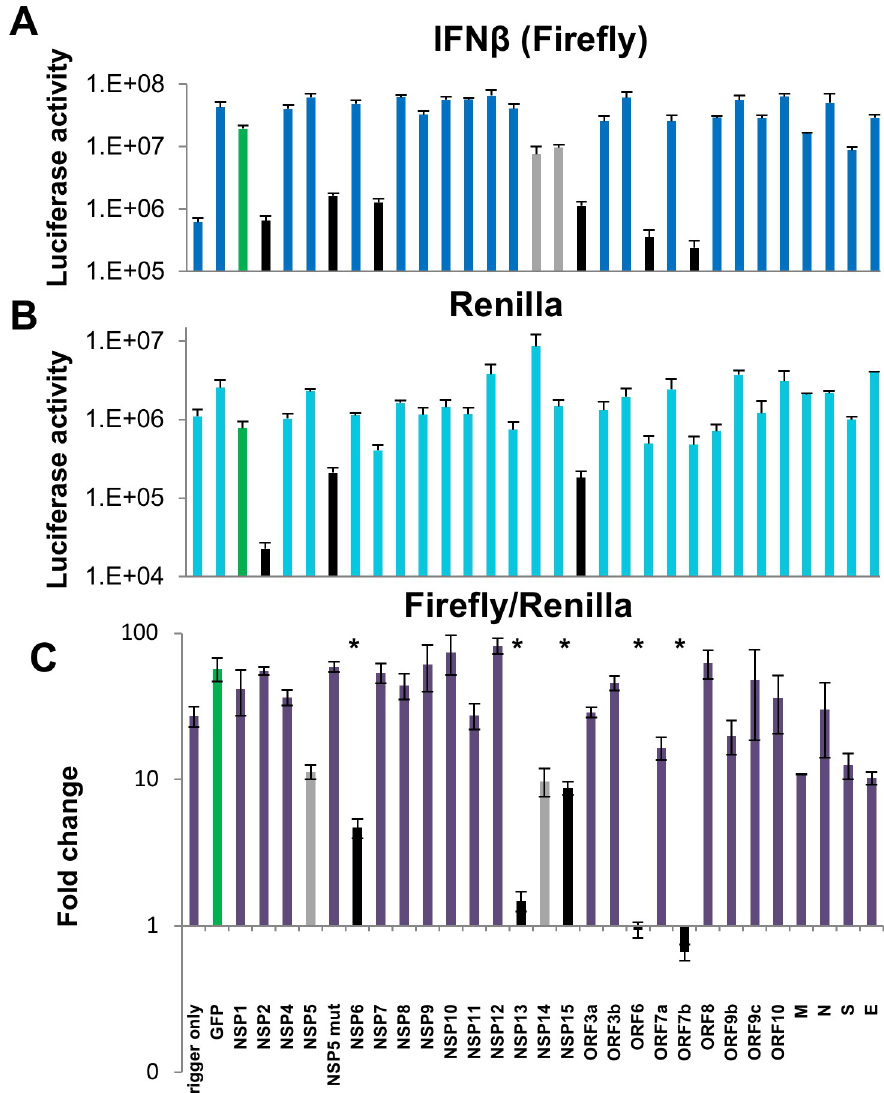
Fig 2. Suppression of MAVS induced IFN β -luciferase promotor activation by SARS-CoV-2 genes. HEK-293T cells were co-transfected with IFN β -firefly luciferase, Renilla luciferase, MAVS and a SARS-CoV-2 viral genes. ’No trigger’ refers to cells transfected with Firefly and Renilla only (but no MAVS); ’Trigger only’ refers to cells transfected with all components but without a viral gene. 24 hours post transfection luciferase activity was measured. IFN β -firefly (A), Renilla normalization signal (B) and normalized Firefly/Renilla luciferase (C) activities are presented separately. Data presented are means pooled from four independent experiments and their standard errors. Significance values are given in comparison to the GFP positive control (green bar): � P < 0.05. Black bars in the plot: 10-fold or greater repression of MAVS-induced promoter activity in comparison to the GFP control. Grey bars in histograms: Minor ( < 10-fold) repression of MAVS-induced IFN β